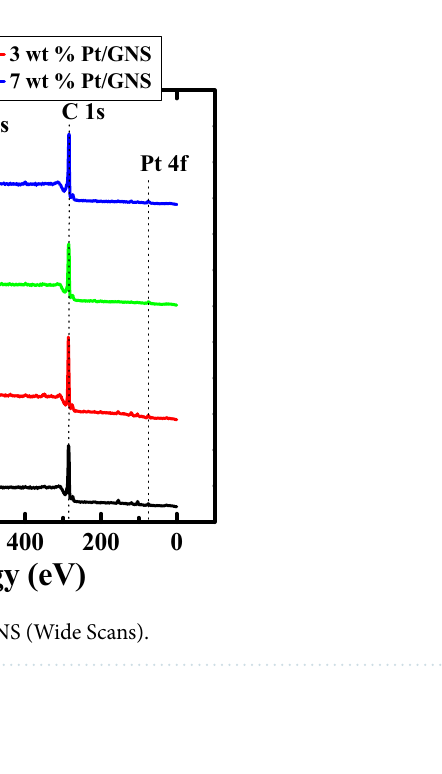
Figure 5. Average Pt particle size (nm) estimated by TEM versus Pt amount on GNS.